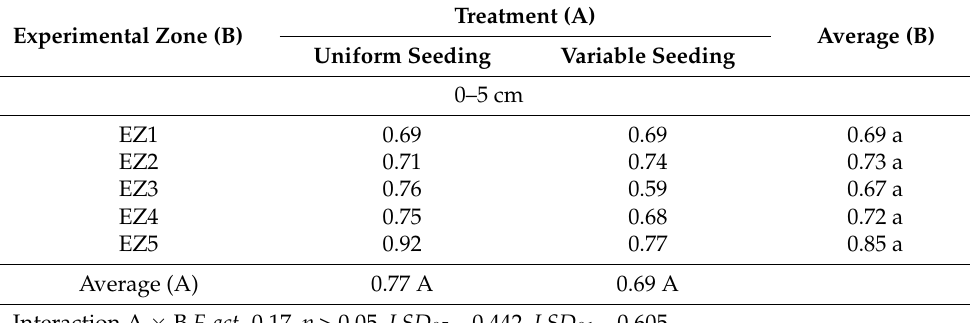
Table 3. Soil penetration resistance for different zones, seeding treatments of experiments and depths